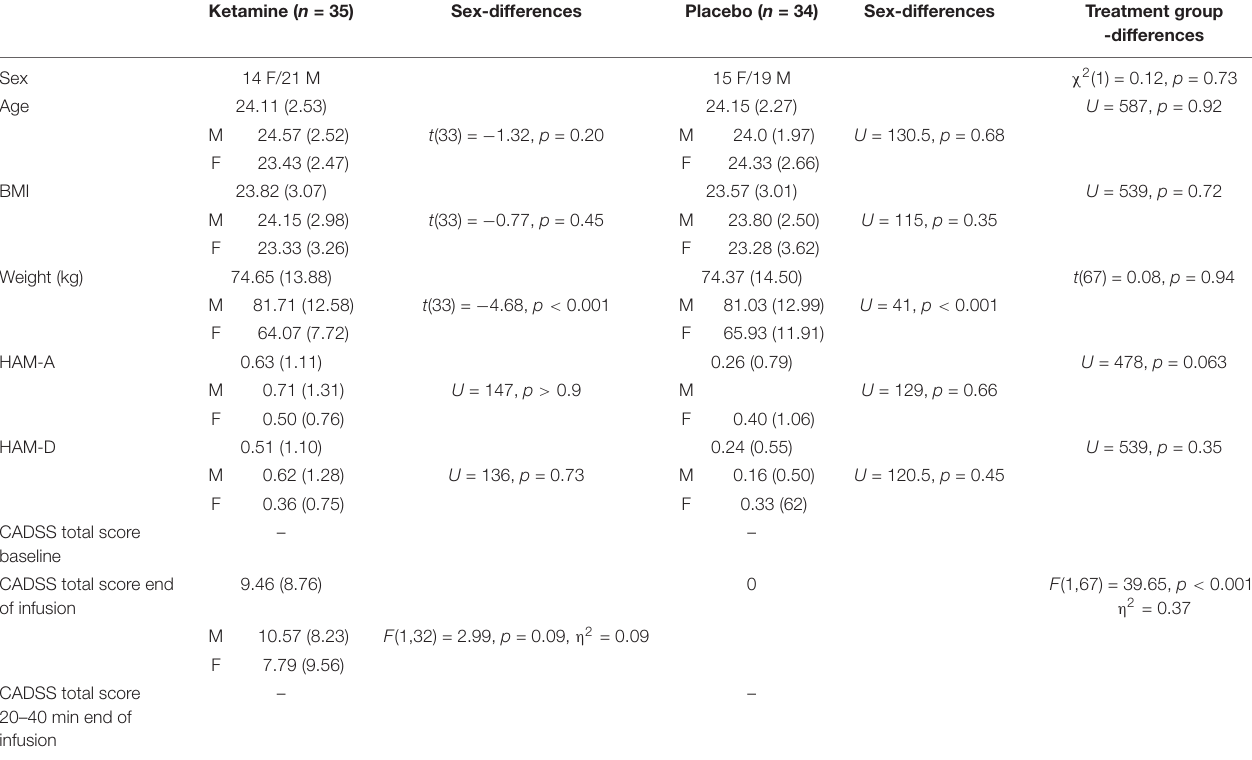
TABLE 1 | Demographic details of the ketamine and placebo group for female and male